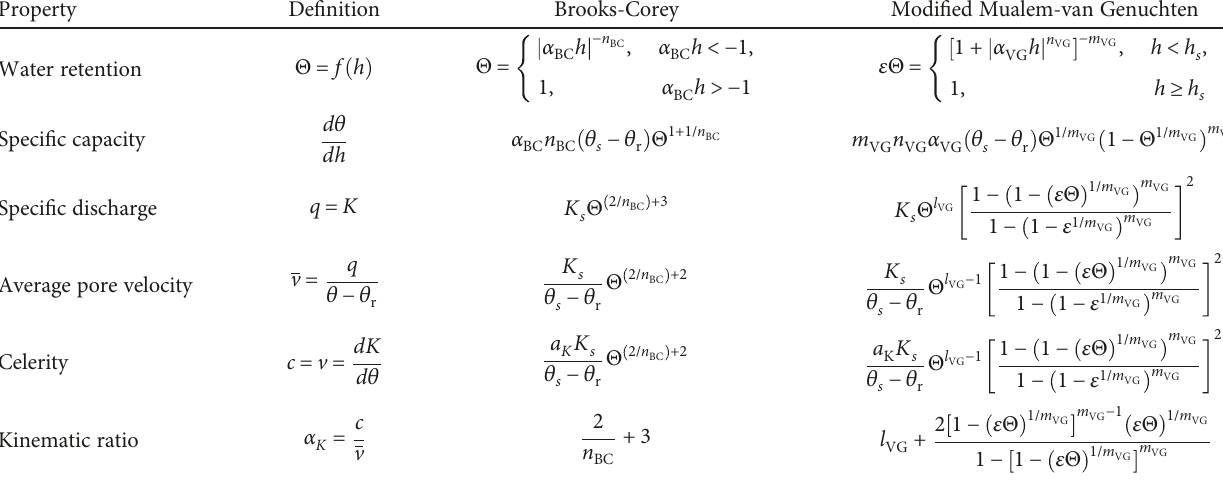
Notation of table: α (L − 1 ), n ( − ), and m ( − ) are the fi tting parameters for the Brooks-Corey model (detonated with subscription of “ BC ” ) and the Mualem-van Genuchten model (detonated with subscription of “ VG ” ); Θ is the e ff ective saturation ( − ) that is de fi ned as Θ = θ − θ modify the van-Genuchten model ε = θ s − θ when θ m = θ s ; and l